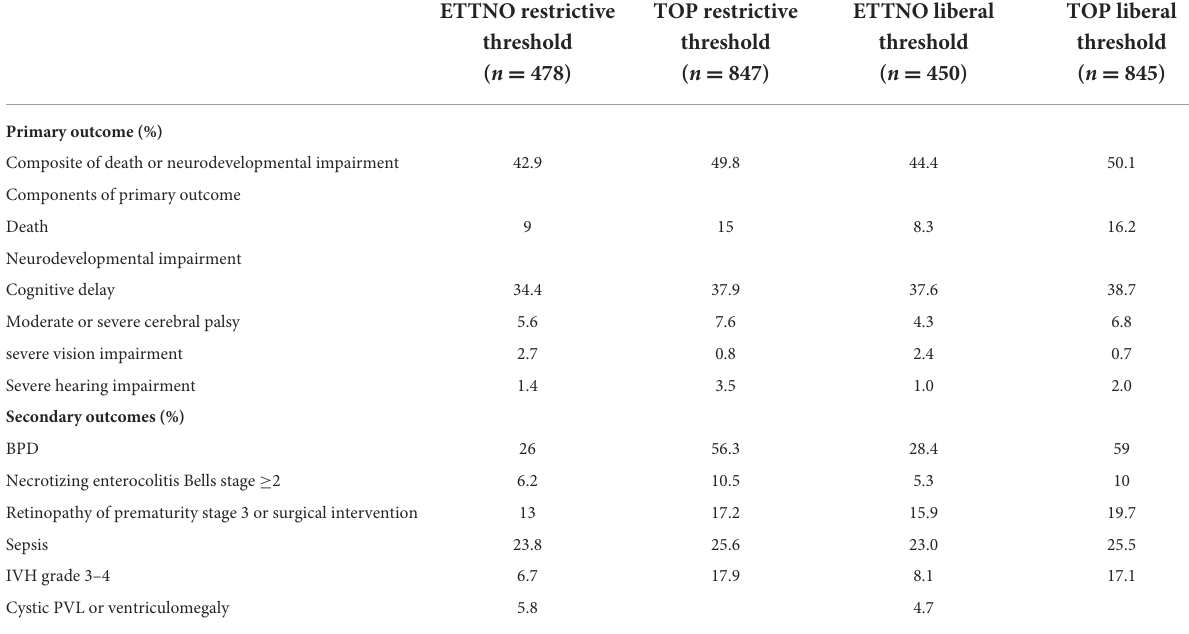
TABLE 2 Comparison of primary and secondary outcomes in restrictive and liberal transfusion groups in ETTNO and TOP studies.